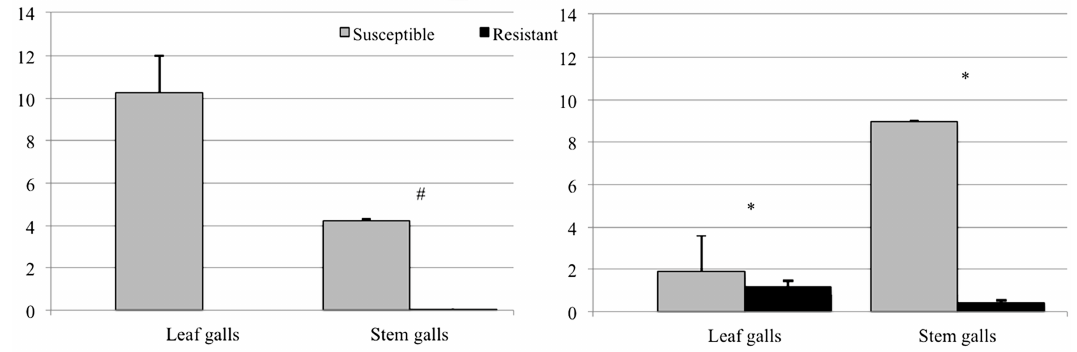
Figure 3. Stem and leaf galls on RSE and susceptible chestnuts in 2016 ( left ) and 2017 ( right ). Bars with # are significantly different at the 5% level, as determined by Kruskal Wallis test; bars with * are significantly different at the 5% level, as determined by ANOVA test.